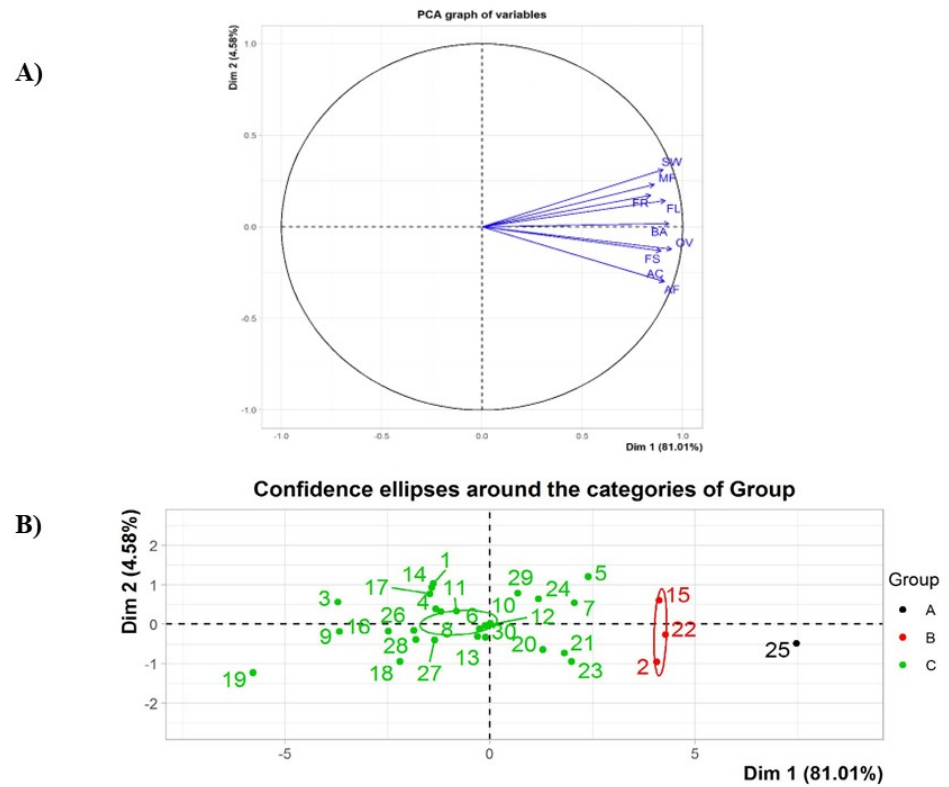
Figure 4. Variables eigenvectors: Variables: fragrance (FR), flavor (FL), aftertaste (AF), acidity (AC), sweet (SW), taste (MF), balance (BA), overall (OV) and final score (FS) ( A ). Scatter diagram in relation to the first two principal components, obtained from the sensory characteristics, of 30 coffees obtained from 5 treatments of Conilon ( Coffea canephora ) and 6 farms ( B ).